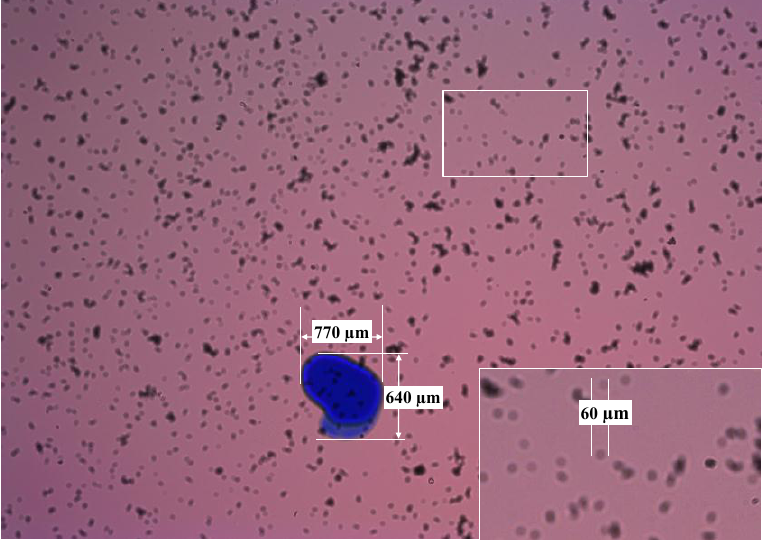
Figure 20. Sample image acquired with the sensor mounting the Gorilla glass disk of 1.1 mm.